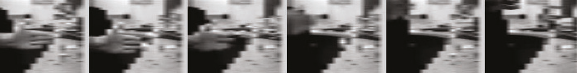
Figure 13: ϕ 1 ( z ).